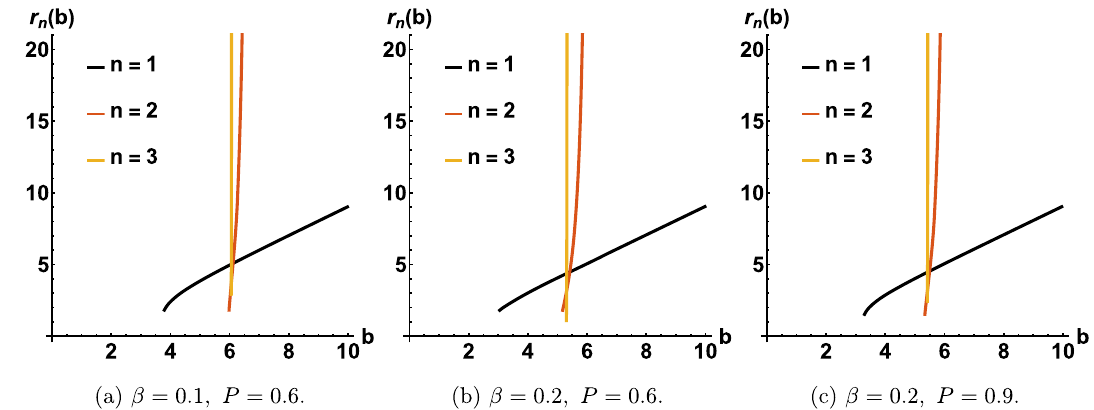
black dashed lines. The black disk represents the BH. The difference in impact parameters between two adjacent trajectories are 0 . 05, 10 − 3 , and 10 − 4 in direct emission, lens ring, and photon ring, respectively